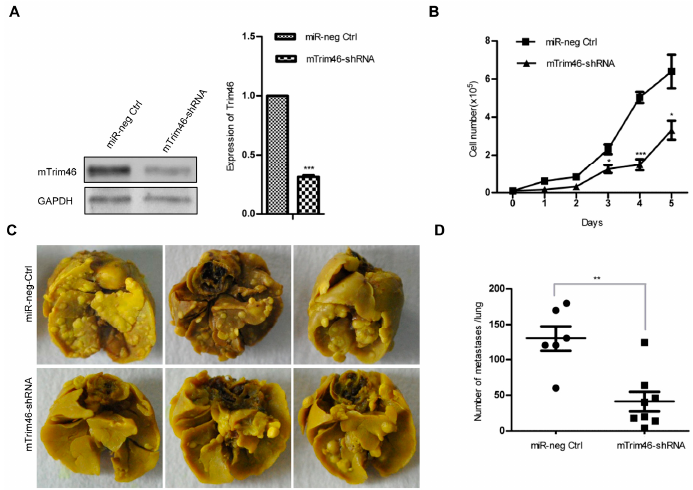
Figure 3. Knockdown of m-Trim46 inhibited cell proliferation and metastasis. ( A ) The expression of Trim46 in the m-Trim46-shRNA stable expression 4TO7 cell line was determined by western blot. GAPDH was used for normalization. *** indicates p < 0.001 versus control; ( B ) Growth curves of mTrim46-shRNA stable expression cell lines at indicated time. * indicates p < 0.05; *** indicates p < 0.001 versus control; ( C ) Representative photos of lung metastasis nodules of mTrim46-shRNA stable expression cell lines; and ( D ) The number of metastasis nodules in ( D ) was calculated ( n = 6 for control; n = 8 for mTrim46-shRNA). ** indicates p < 0.01 versus control.